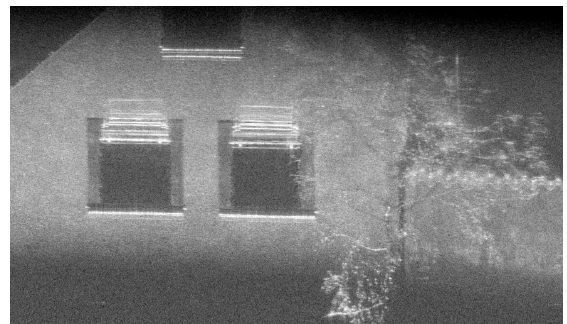
Figure 8: SAR image result of house facade. The sensor is look- ing upwards with an incidence angle of ∼ 30 degrees. The first and second floor of a house front with plastered walls is visible. A tree tied to the rain pipe is beneath the right window. Multipath effects and strong echoes from the window benches and roller shutters show strong characteristics. The resolution is 5 mm with a pixel spacing of 2 mm. The perpendicular distance of the house to the moving radar sensor was about 7